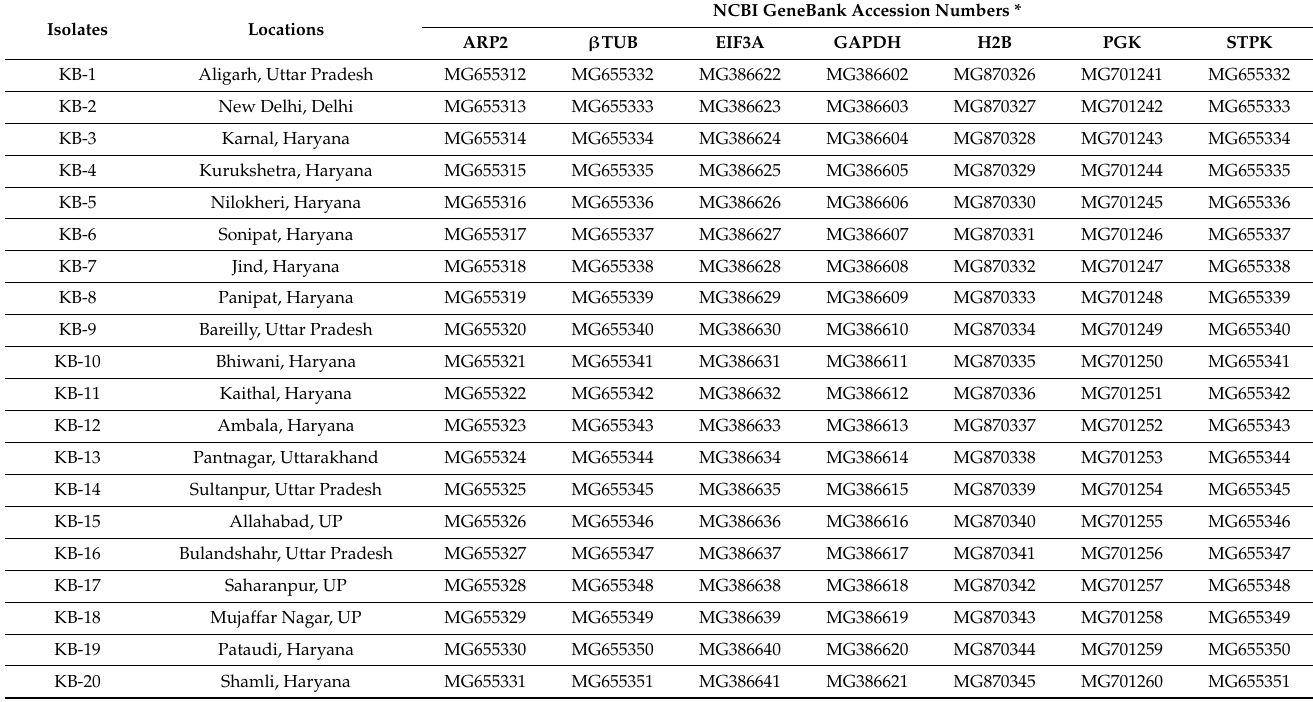
Table 2. Tilletia indica isolates GenBank accession numbers of generated sequences of different genes.